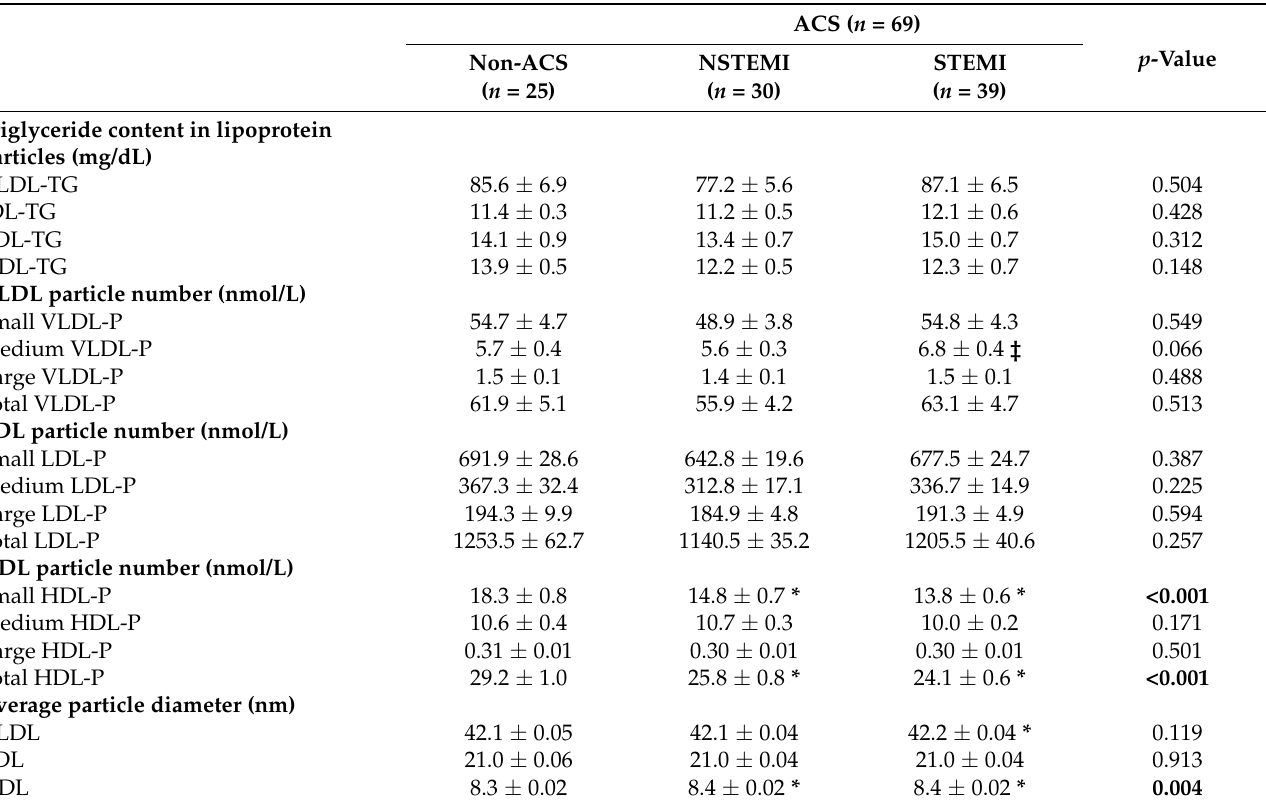
Table 2. Lipoprotein particle number and size. Results are expressed as mean ± SEM. The ANOVA test was applied for multiple comparisons; the Bonferroni post hoc test was run for two group comparisons after ANOVA: * , significant changes versus non-ACS group; ‡ , significant changes between NSTEMI and STEMI groups. Values of p < 0.05 are considered significant. Abbrevia- tions: ACS = acute coronary syndrome, NSTEMI = non-ST-segment-elevation myocardial infarc- tion, STEMI = ST-segment-elevation myocardial infarction, VLDL = very low density lipoprotein, IDL = intermediate density lipoprotein, HDL = high density lipoprotein, TG =